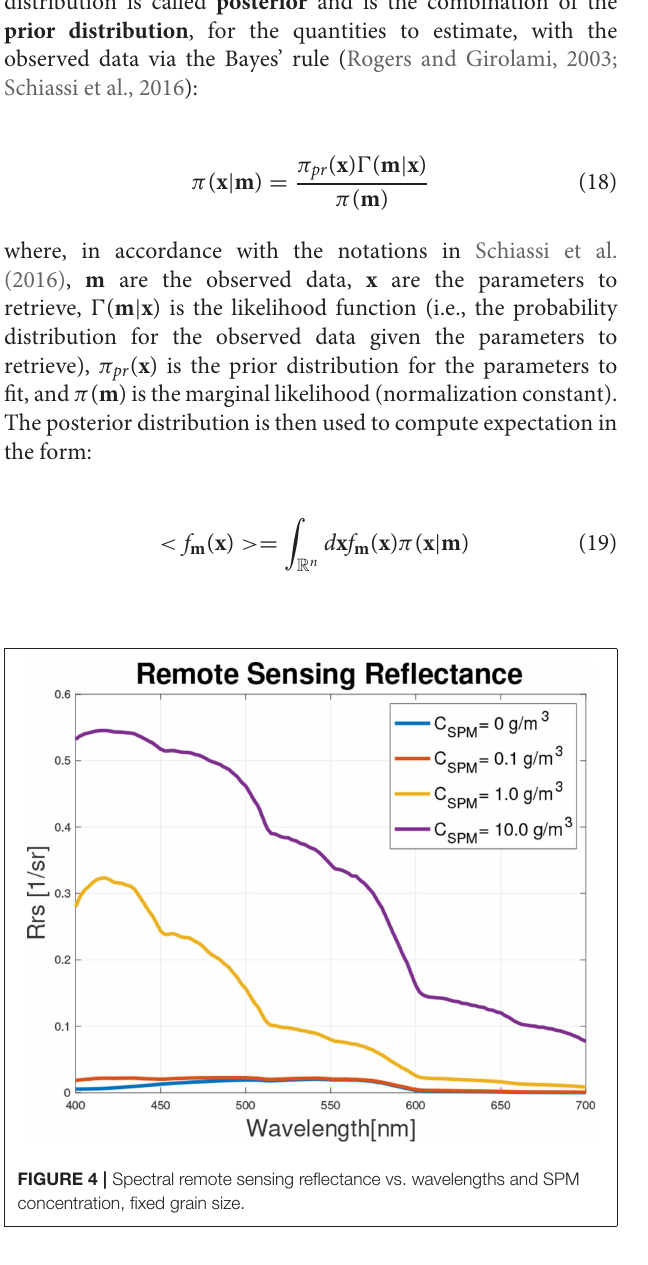
TABLE 3 | Simulated scenarios for SPM grain size variation, fixed concentration.